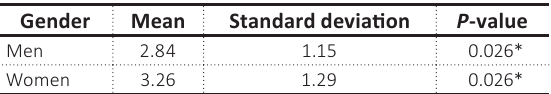
Table 8. Job satisfaction and pay